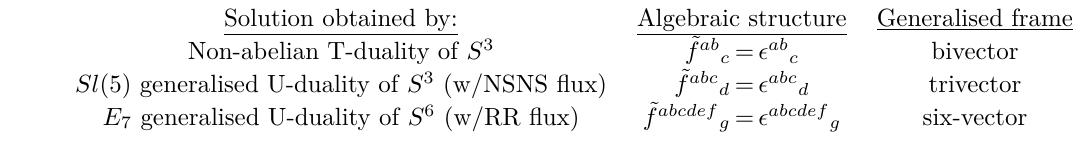
Table 1 . Properties of generalised